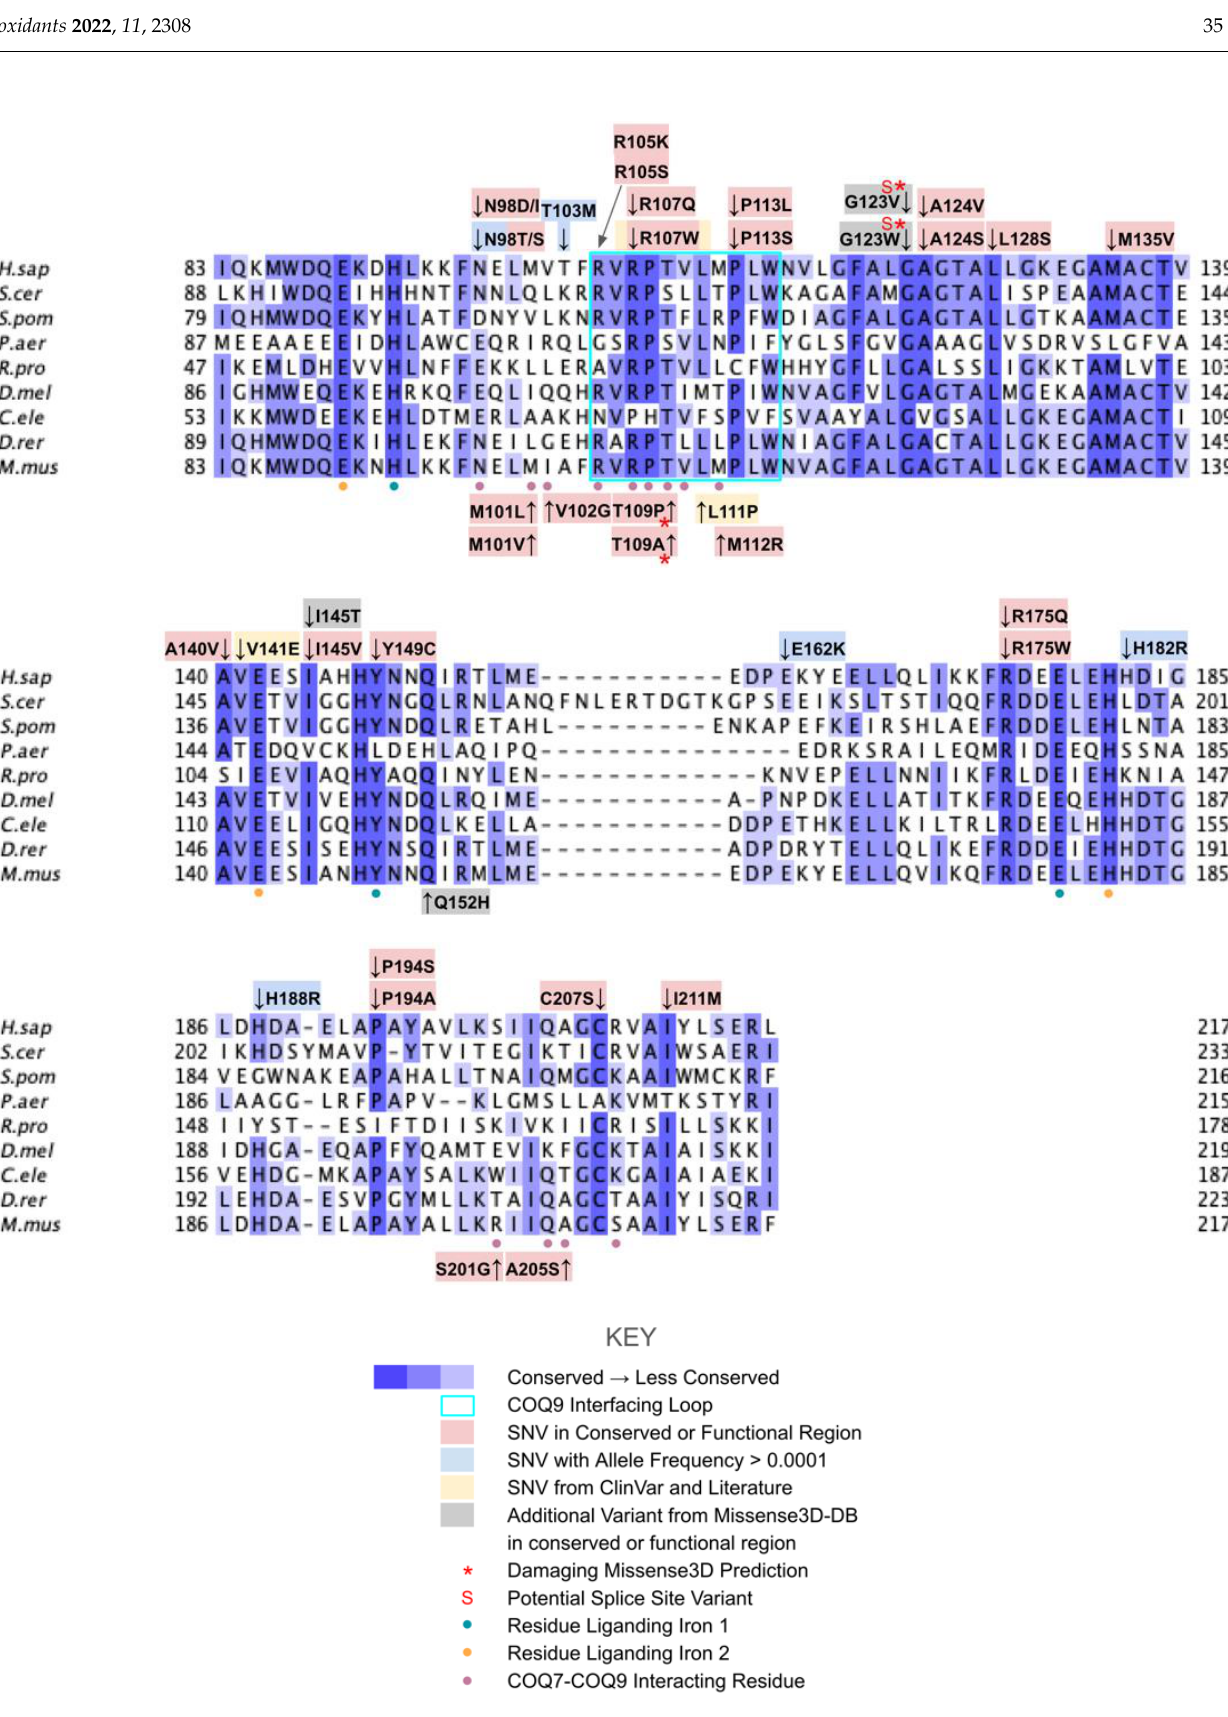
Figure 24. Labeled and annotated multiple sequence alignment of COQ7. Amino acid sequences of COQ7 were analyzed as described in Materials and Methods and include Homo sapiens (NCBI accession number NP_057222.2) and homologs in Saccharomyces cerevisiae (NP_014768.2),